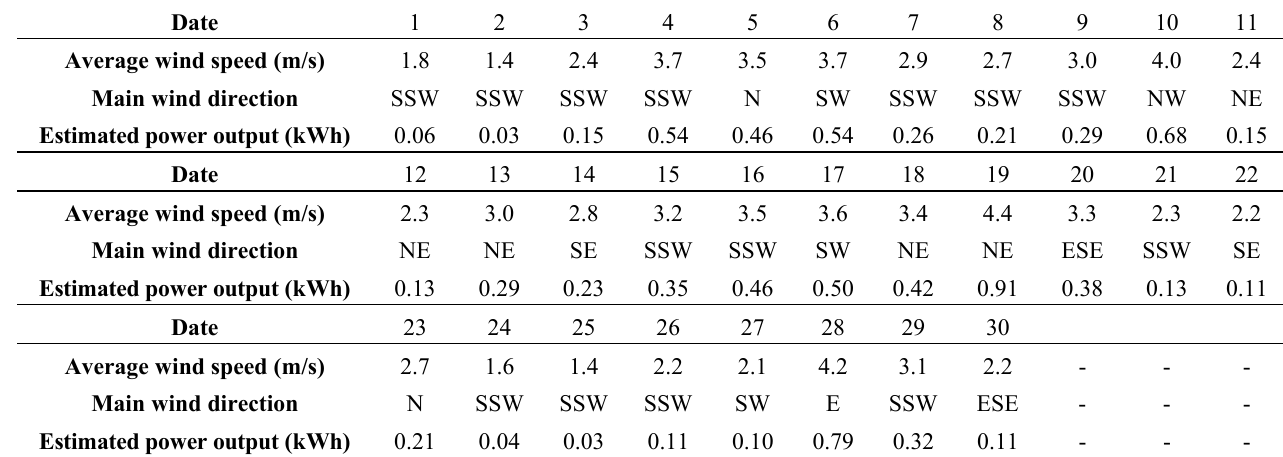
Table A4. Estimated power output per day in April.